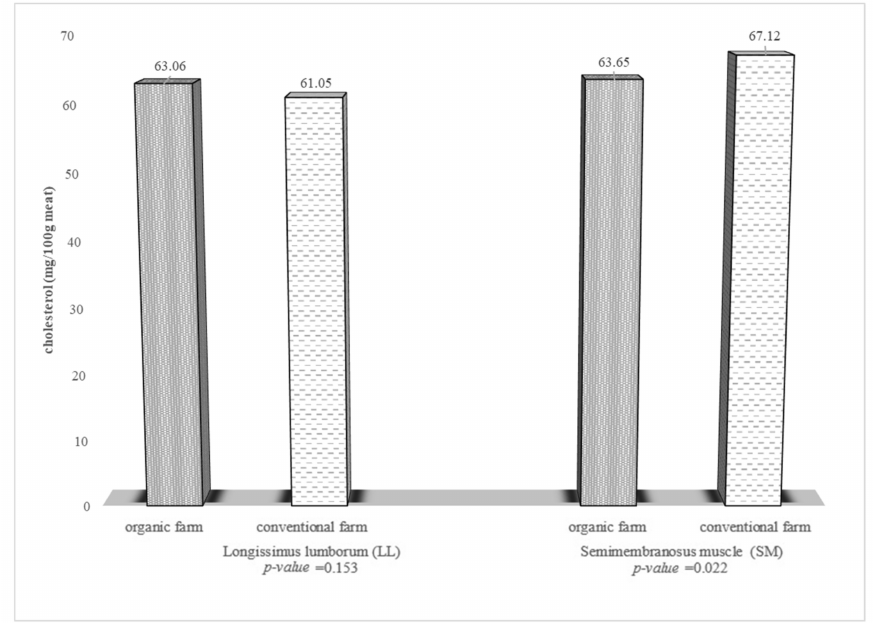
Figure 2. Cholesterol content (mg/100 g meat) in the meat of fallow deer from organic and conventional